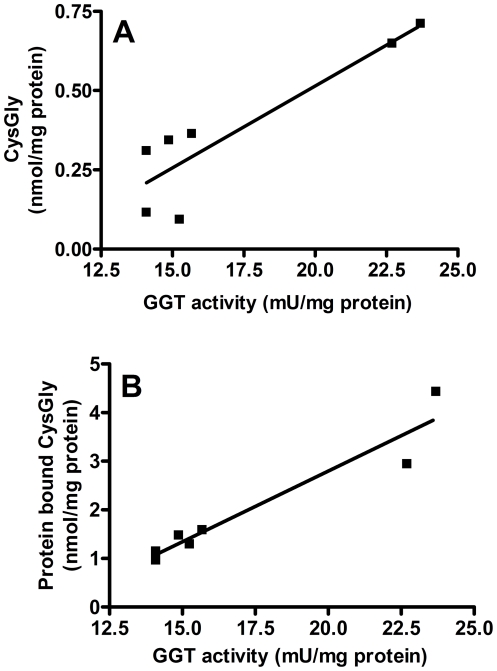
Relationship between GGT activity and cysteinyl-glycine (CysGly) levels in whole sputum.Data were obtained from seven different samples of CF sputum. (A) Free and (B) protein bound CysGly. A) R2 = 0,811, p<0.01; B) R2 = 0,917, p<0.001.